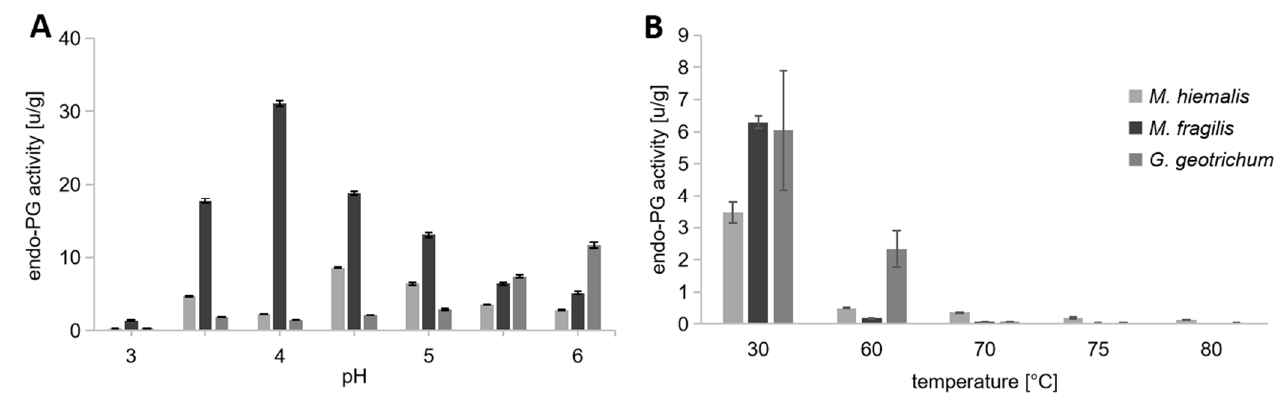
Figure 7. Endo-Polygalacturonase activity of fungal-inoculated gherkins. Cucumber bouillons were inoculated with the fungi Mucor hiemalis , Mucor fragilis, or Galactomyces geotrichum . All enzymatic measurements were performed in triplicate (n = 3). ( A ) The endo-PG activity [u/g] induced by the fungi was measured in the pH range of 3.0 to 6.0 (increase in 0.5 increments). Due to the low endo-PG activities observed in the control measured at pH 5.5, no further tests were performed with it at other pH values. The temperature was fixed at 30 ◦ C during measurement. ( B ) The endo-PG activity induced by the fungi was measured in the temperature range of 30 ◦ C to 80 ◦ C (fixed pH at 5.5). In addition, further trials with varying temperatures between 30 ◦ C and 80 ◦ C and fixed pH at 5.5 were performed to investigate the heat tolerance of the enzyme. The aim